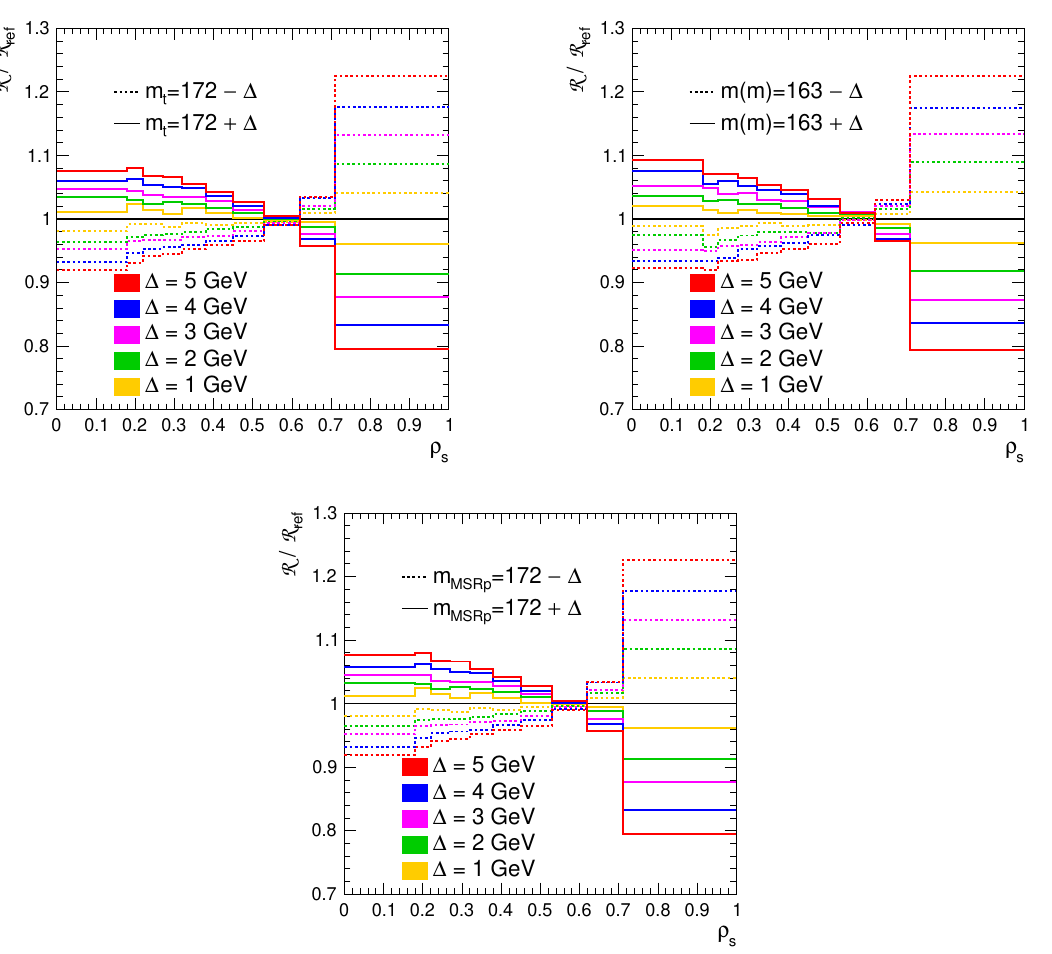
Figure 36 . Ratios of R distributions using as input different top-quark mass values and the R distribution obtained with a fixed central top-quark mass value (assumed to be equal to 173 GeV in all renormalization schemes). Different panels refer to different renormalization schemes for the top-quark